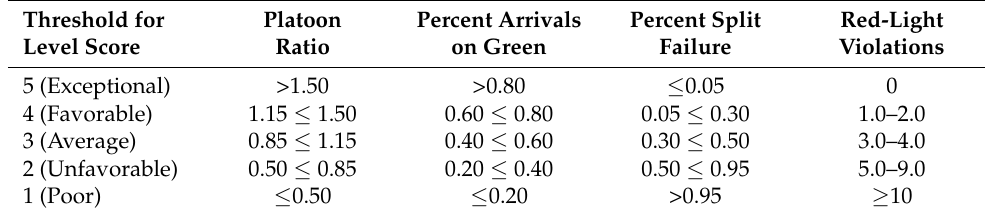
Table 2. Performance Measure Threshold